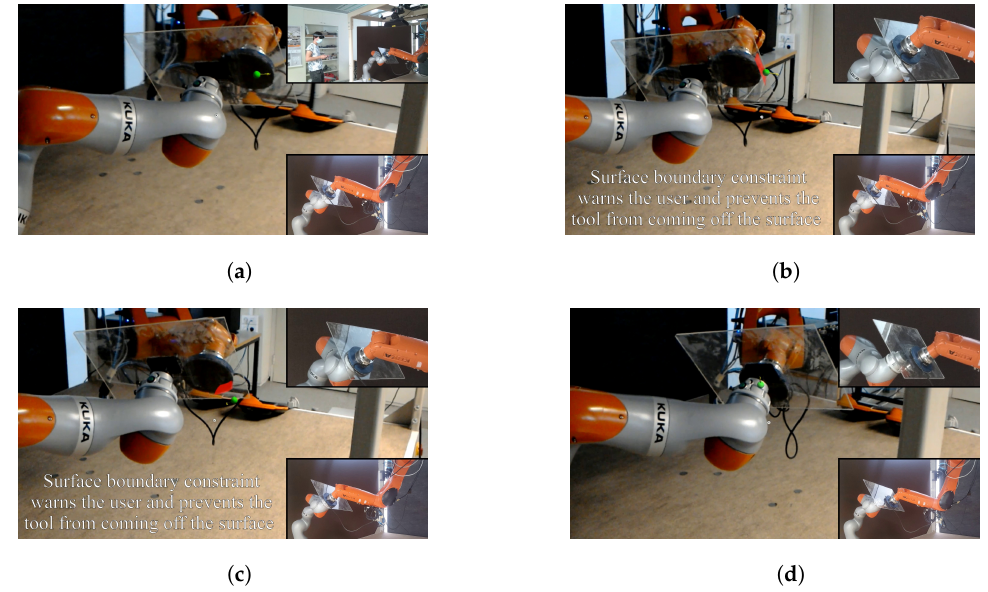
Figure 10. Second experiment: frames of the video showing the performance of the 2D boundary and the STR reference hologram. See the video at https://media.upv.es/player/?id=9504e6f0-8a61- 11ec-b7c7-7d27dda7c5d5 (accessed on 26 April 2022) [82]. ( a ) Video: 0 m 31 s. ( b ) Video: 0 m 41 s.